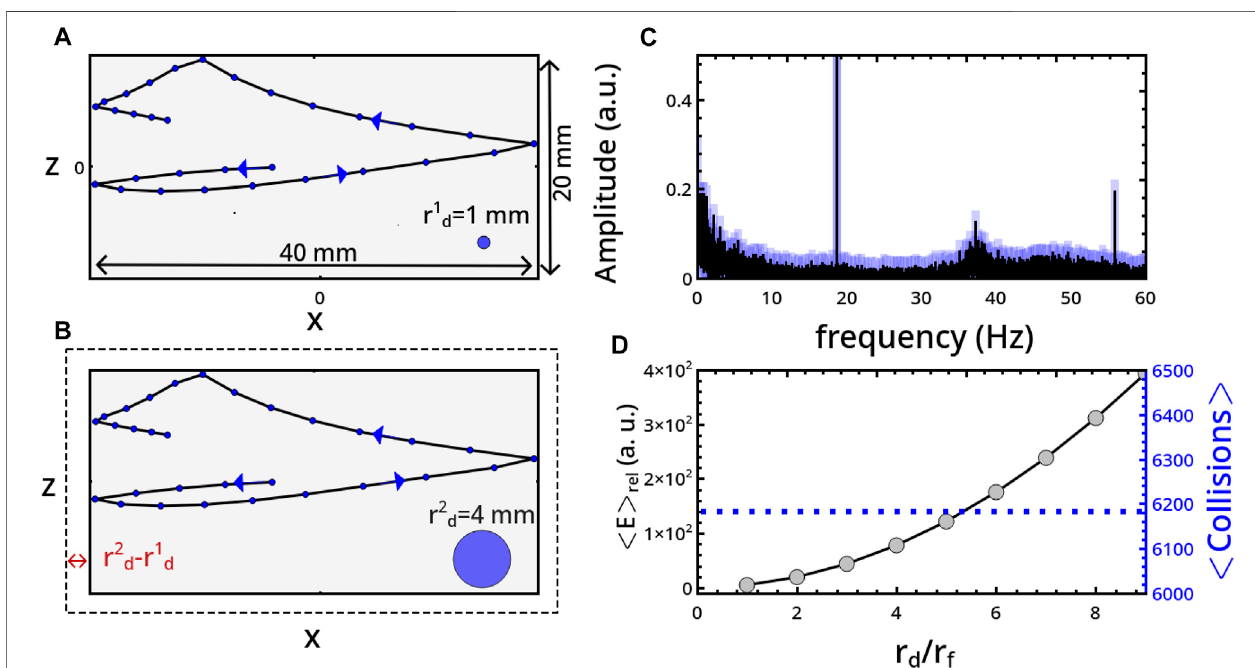
FIGURE9| Comparisonbetweenthemillingdiscdynamicsobtainedwith r d =1 mm (A) and r d =4 mm (B) (i.e., ϵ =3 mm),byadaptingthespatialdomainfrom Ω f = 20,×,40 mmto Ω f =26×46 mm,accordingto Eqs9 , 10 . f is fi xedto0.5. (C) ComparisonbetweentheFFTsofthe x -displacementofthemillingdiscintime. (D) Average number of collisions on the bases, 〈 Collisions 〉 , and average relative energy per collision, 〈 E 〉 rel , with respect to the reference energy of a milling disc with radius r f = 1